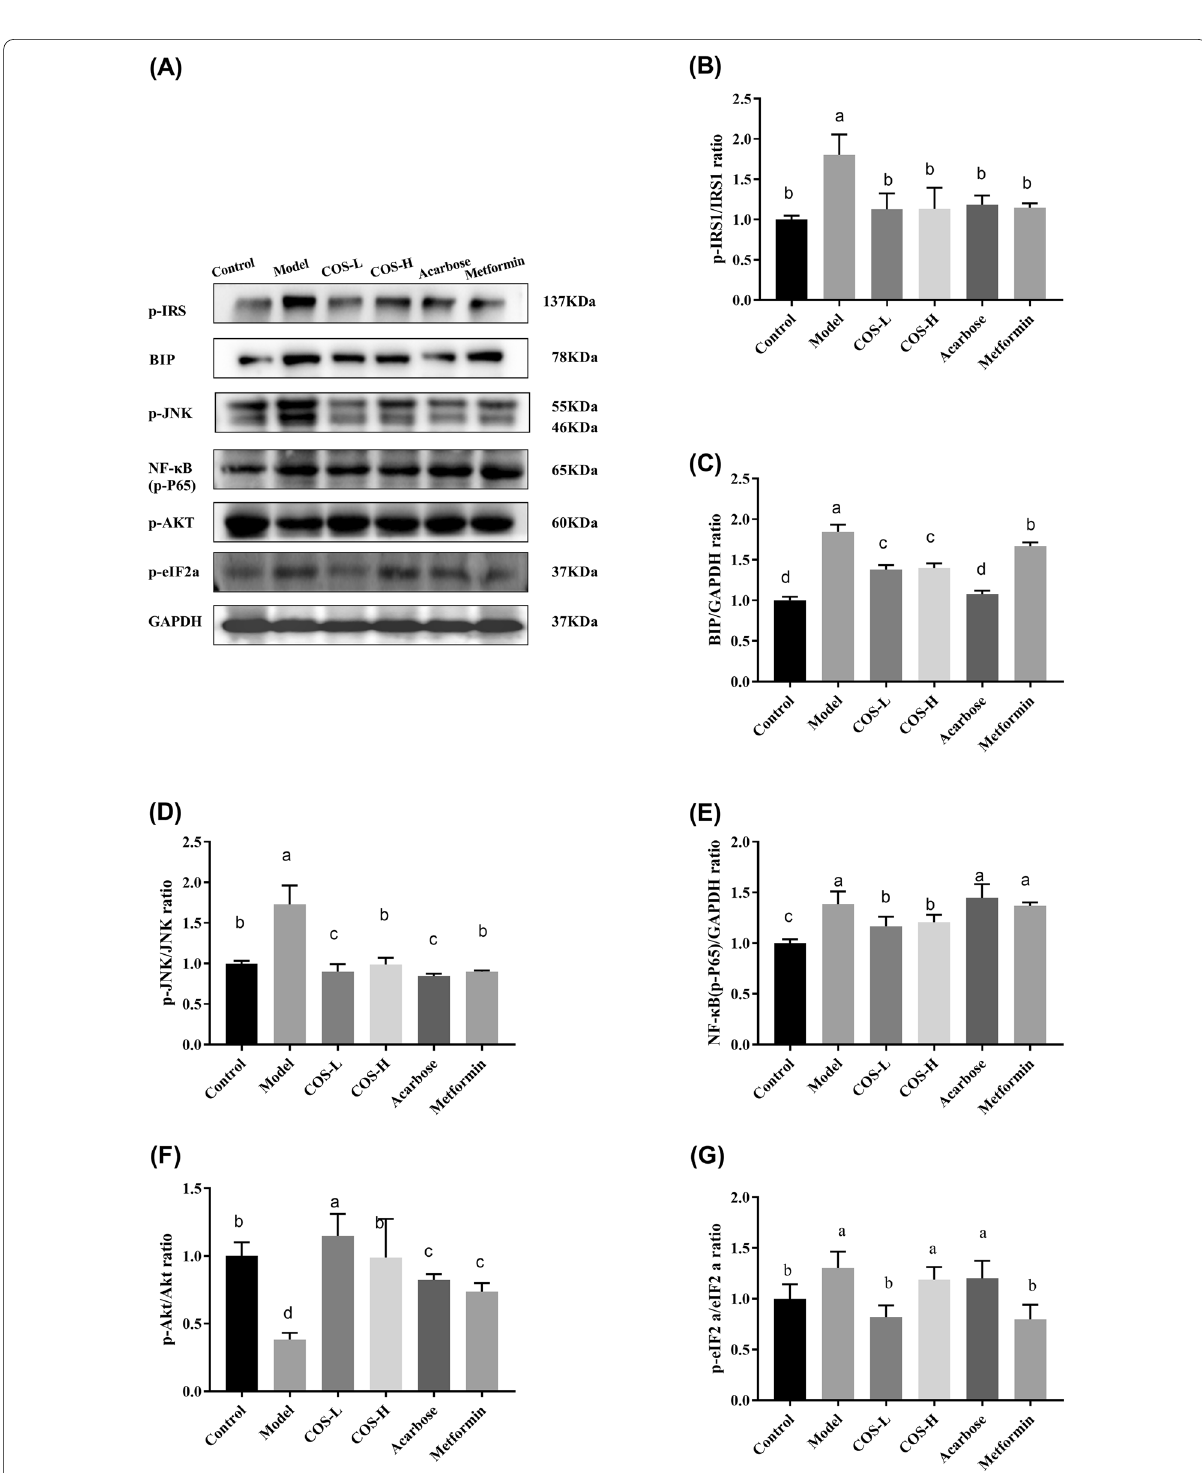
Fig. 10 The expression of the proteins related to the insulin signaling pathway in the mouse livers. A Western blot images, B P-IRS-1 (Ser307)/ GAPDH, C BIP/GAPDH, D p-JNK (Thr183 Tyr185)/GAPDH, E NF-κB (P-p65) (Ser536)/GAPDH, F p-Akt (Ser473)/GAPDH, G p-eIF2A (Ser52)/GAPDH. + Normalization versus GAPDH ensured equal protein